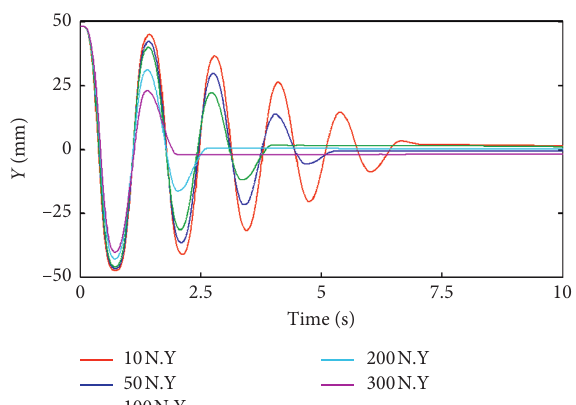
Figure 15: The oscillation curve of the centroid of the platform in Y direction when β � ( π /6 ) and ϕ � ( π /2 ) under different loads between the upper and lower disc valves.